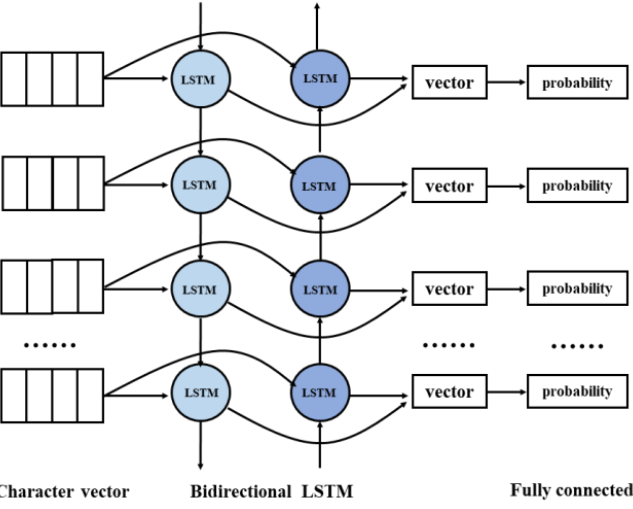
Figure 2. Structure of the segmentation module.